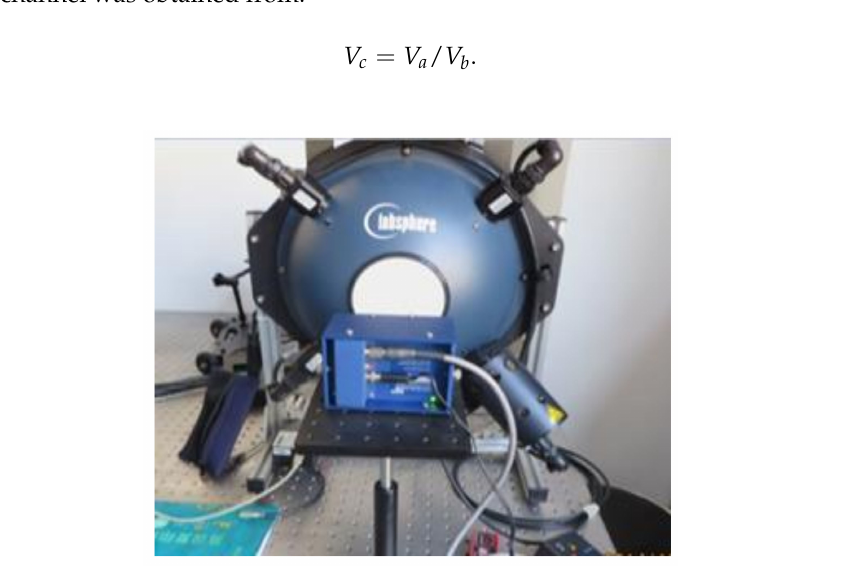
Figure 3. A photo of the uniform source system (CSTM-USS-1200C; Labsphere, Inc., North Sutton, NH,